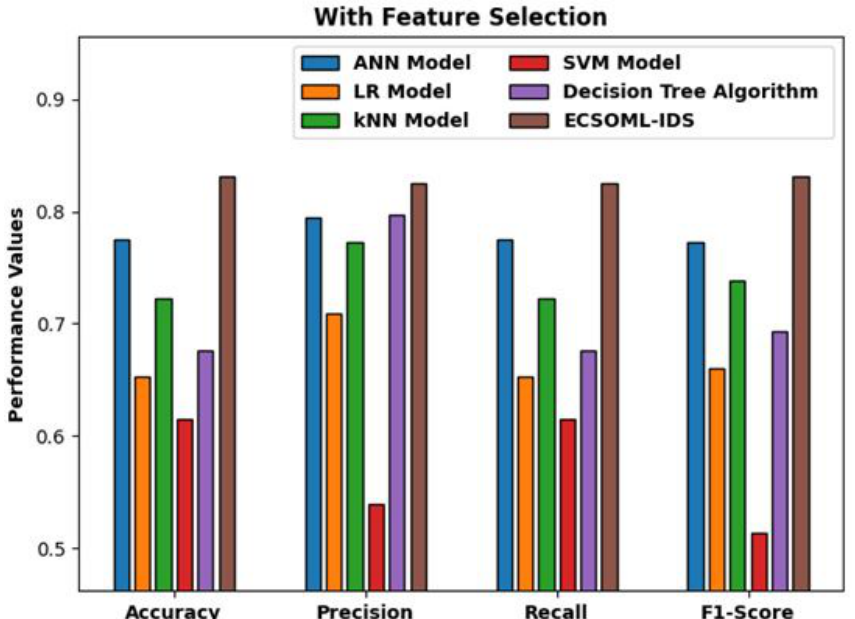
Figure 12. Comparative analysis of DAE-IDS technique with feature